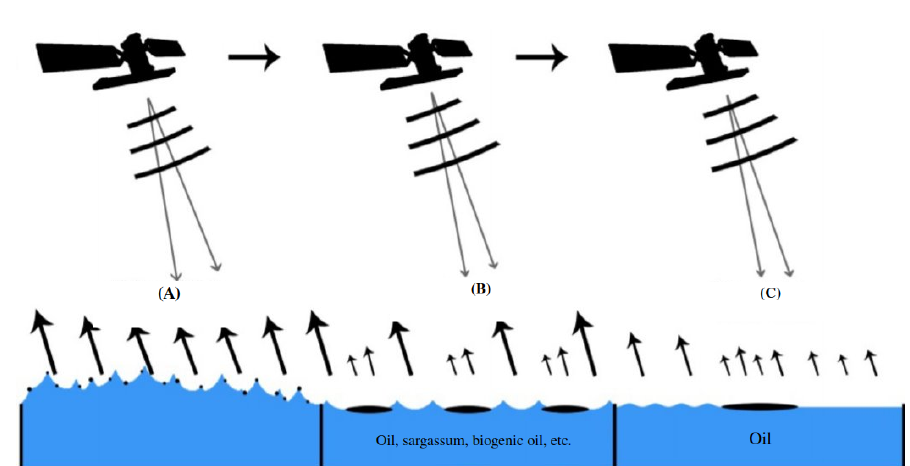
Figure 1. Illustration of SAR backscatter with different sea roughness. The wind conditions at the time of the data collection constrain the backscattered energy properties [13]. (A) represent strong winds (winds > 10 m/s), (B) represent ideal winds (7 m/s> Winds > 3 m/s) and (C) represent weak winds (winds < 3 m/s).